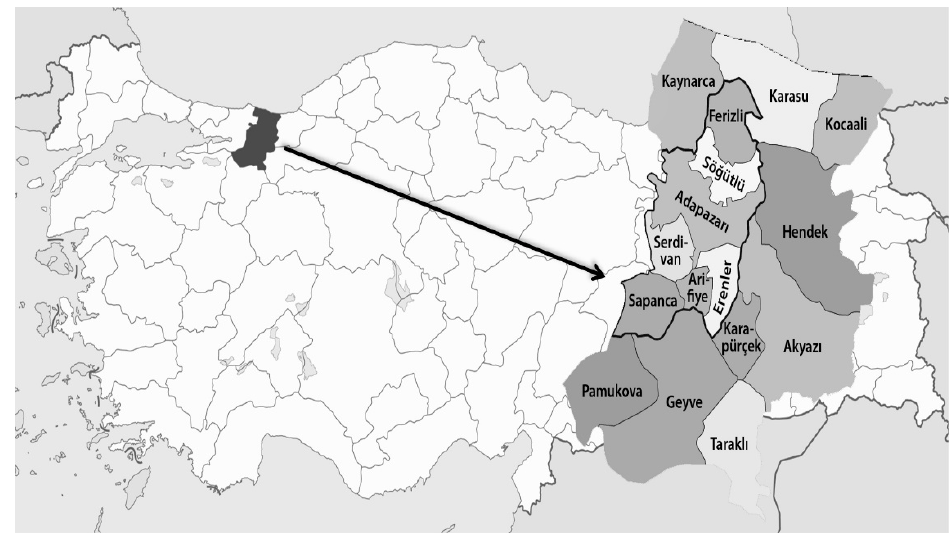
Figure 1. Surveyed locations in the Sakarya province for plant-parasitic nematodes. Table 1. The locations of the plant-parasitic nematodes collected from different wheat fields in the Sakarya province.